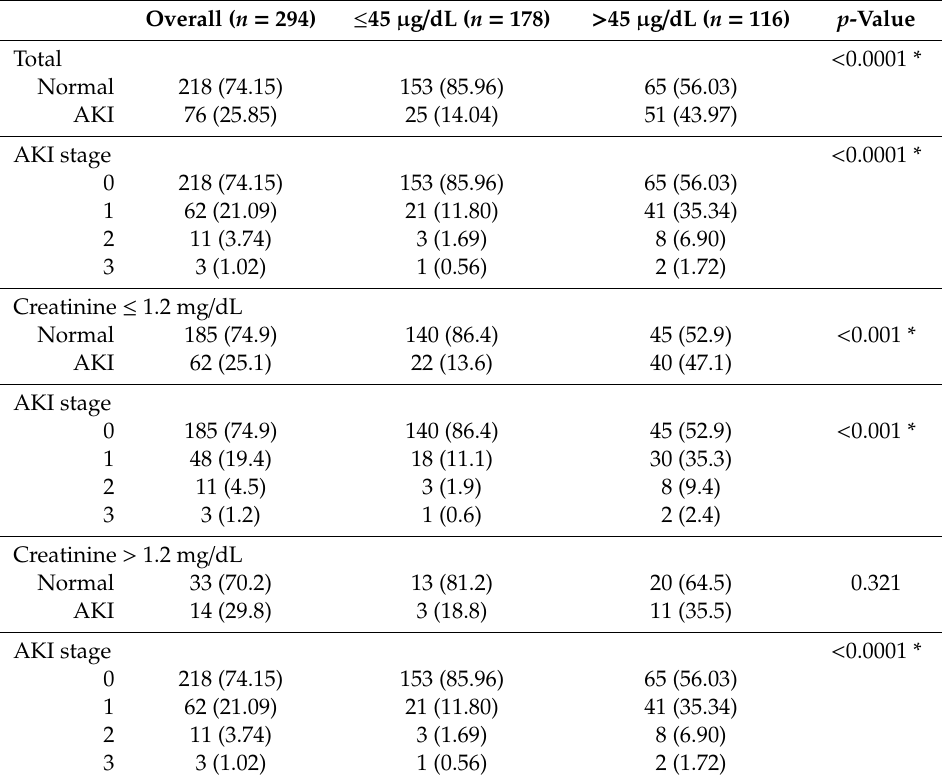
Table 6. Incidence of AKI according to ammonia levels in patients undergoing liver transplantation. Overall ( n = 294) ≤ 45 µ g / dL ( n = 178) > 45 µ g / dL ( n = 116) p -Value